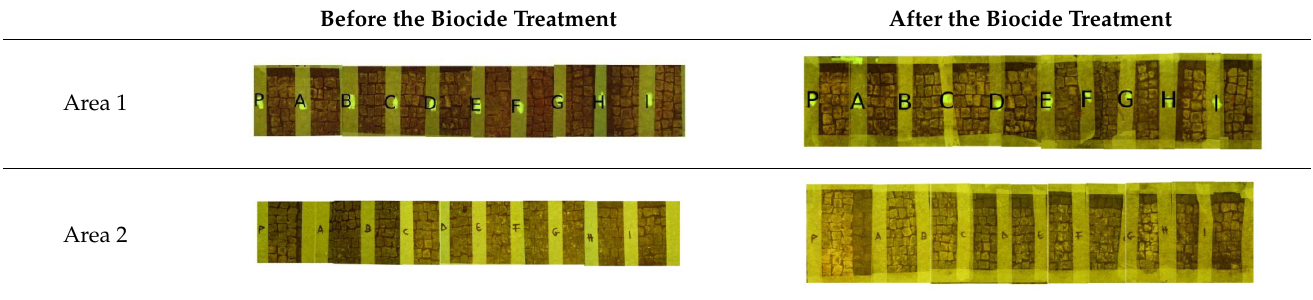
Table 4. Images of areas 1 and 2 before the treatment with EOs and after the cleaning procedure in UVL.